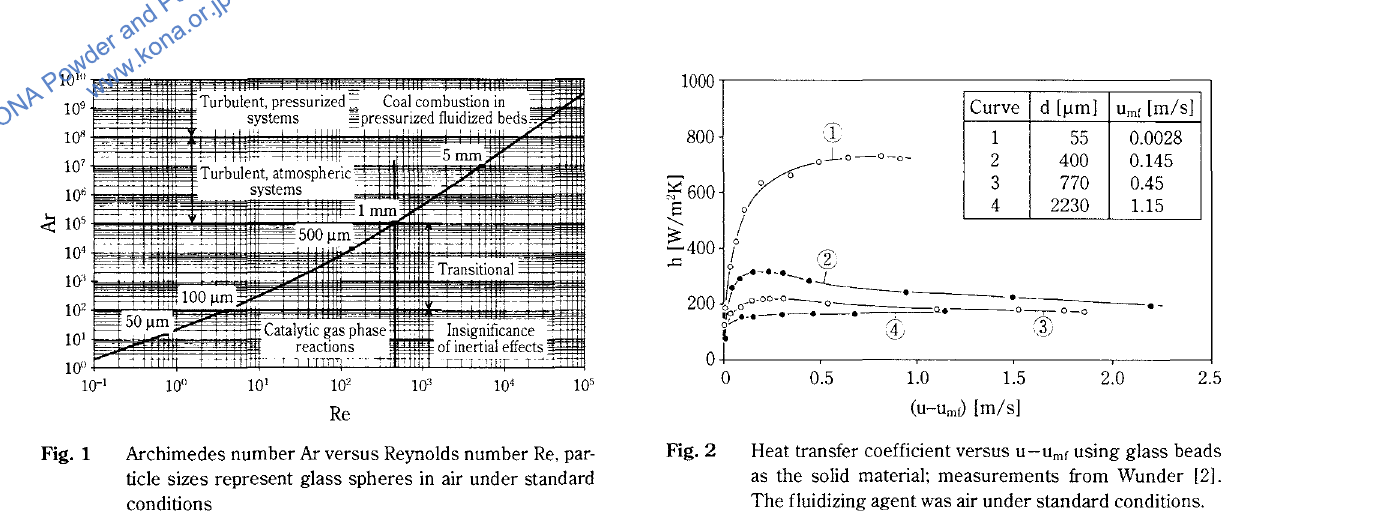
Fig. 2 Heat transfer coefficient versus u -Umr using glass beads as the solid material; measurements from Wunder [2]. The fluidizing agent was air under standard conditions. optical fibre I from the ..... light source